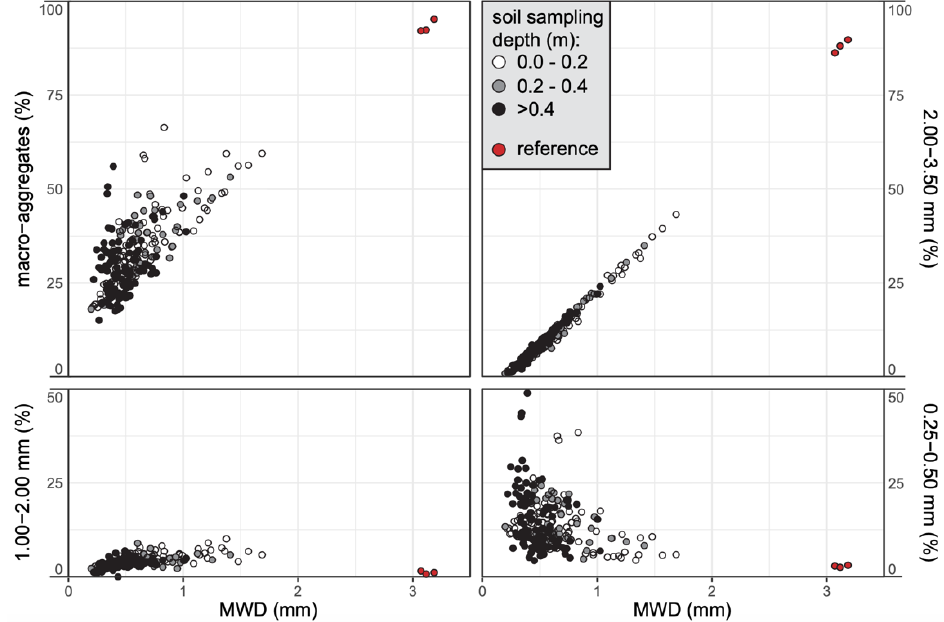
Figure 2. Contribution of the macro-aggregate fraction and associated sub-fractions to the mean weight diameter (MWD) value (% proportion of each sub-fraction to the soil sample dried mass).